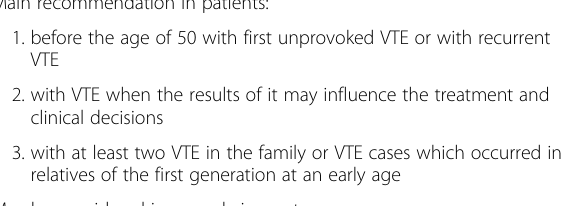
Table 3 Recommendation of ACMG (American College